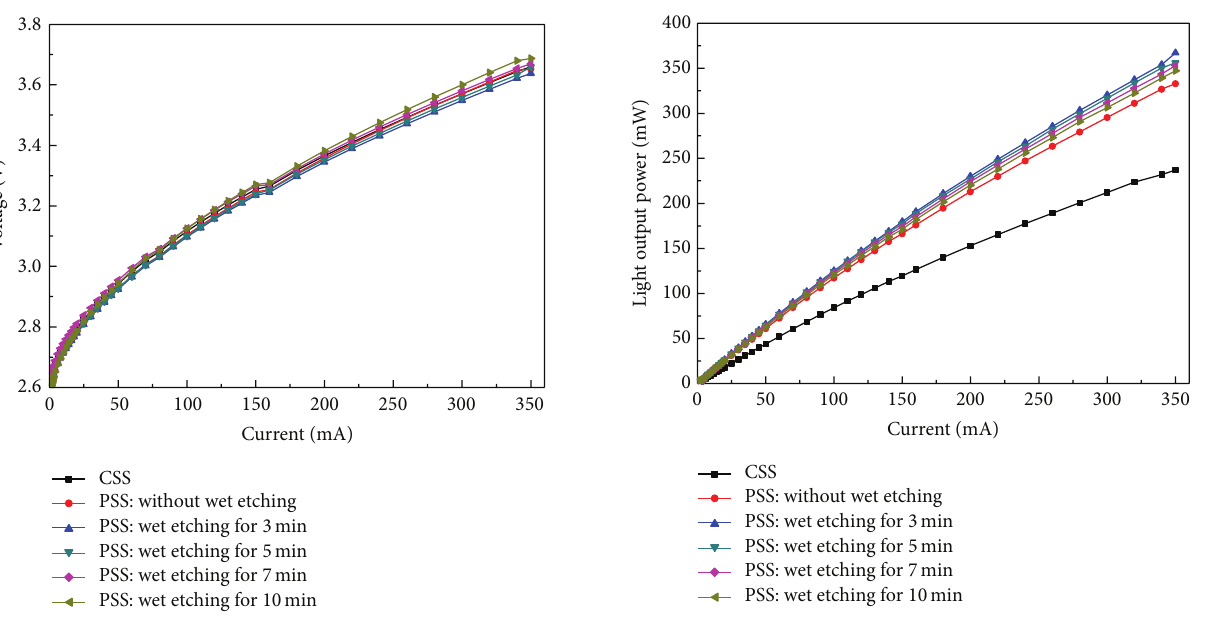
Figure 5: 𝐼 - 𝑉 characteristics of the InGaN LEDs prepared on the CSS and various cone-shaped PSSs subjected to wet etching from 0 to 10min.